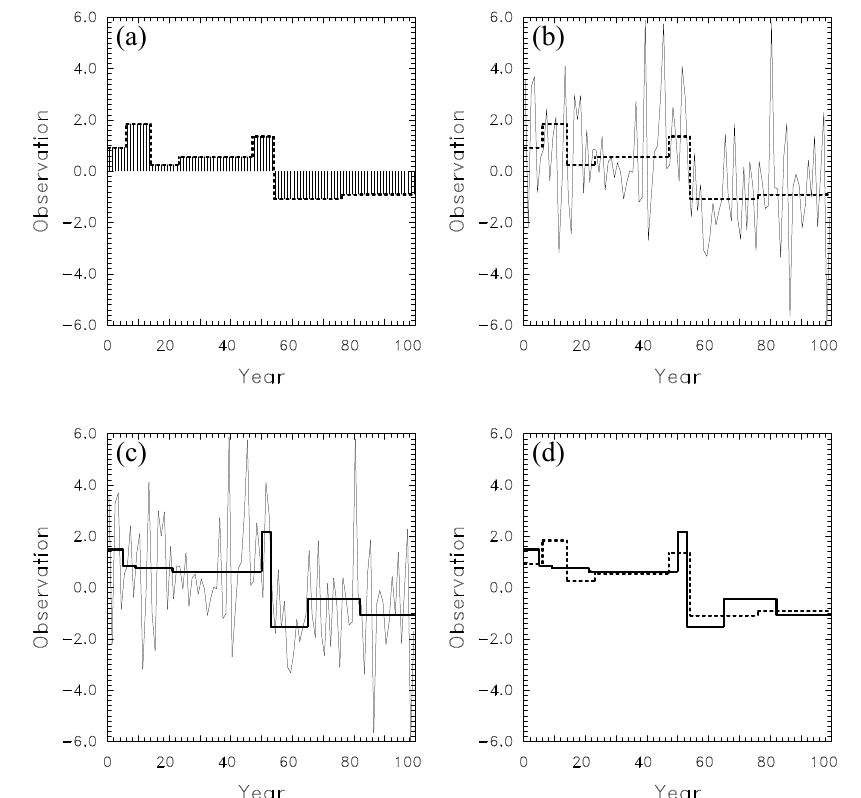
Figure 10. Illustration of the skill measure M2, the mean squared deviation between estimated and true break signals. (a) The time series of inhomogeneities is interpreted as a signal to be detected (dashed step function). (b) The detection of the signal (dashed step function) is hampered by superimposed scatter. (c) Homogenization algorithms search for the maximum external variance of the noisy data. The corresponding estimated signal (step function) is given by the thick line. (d) The mean squared difference between true (dashed) and estimated (solid) signals is an appropriate skill